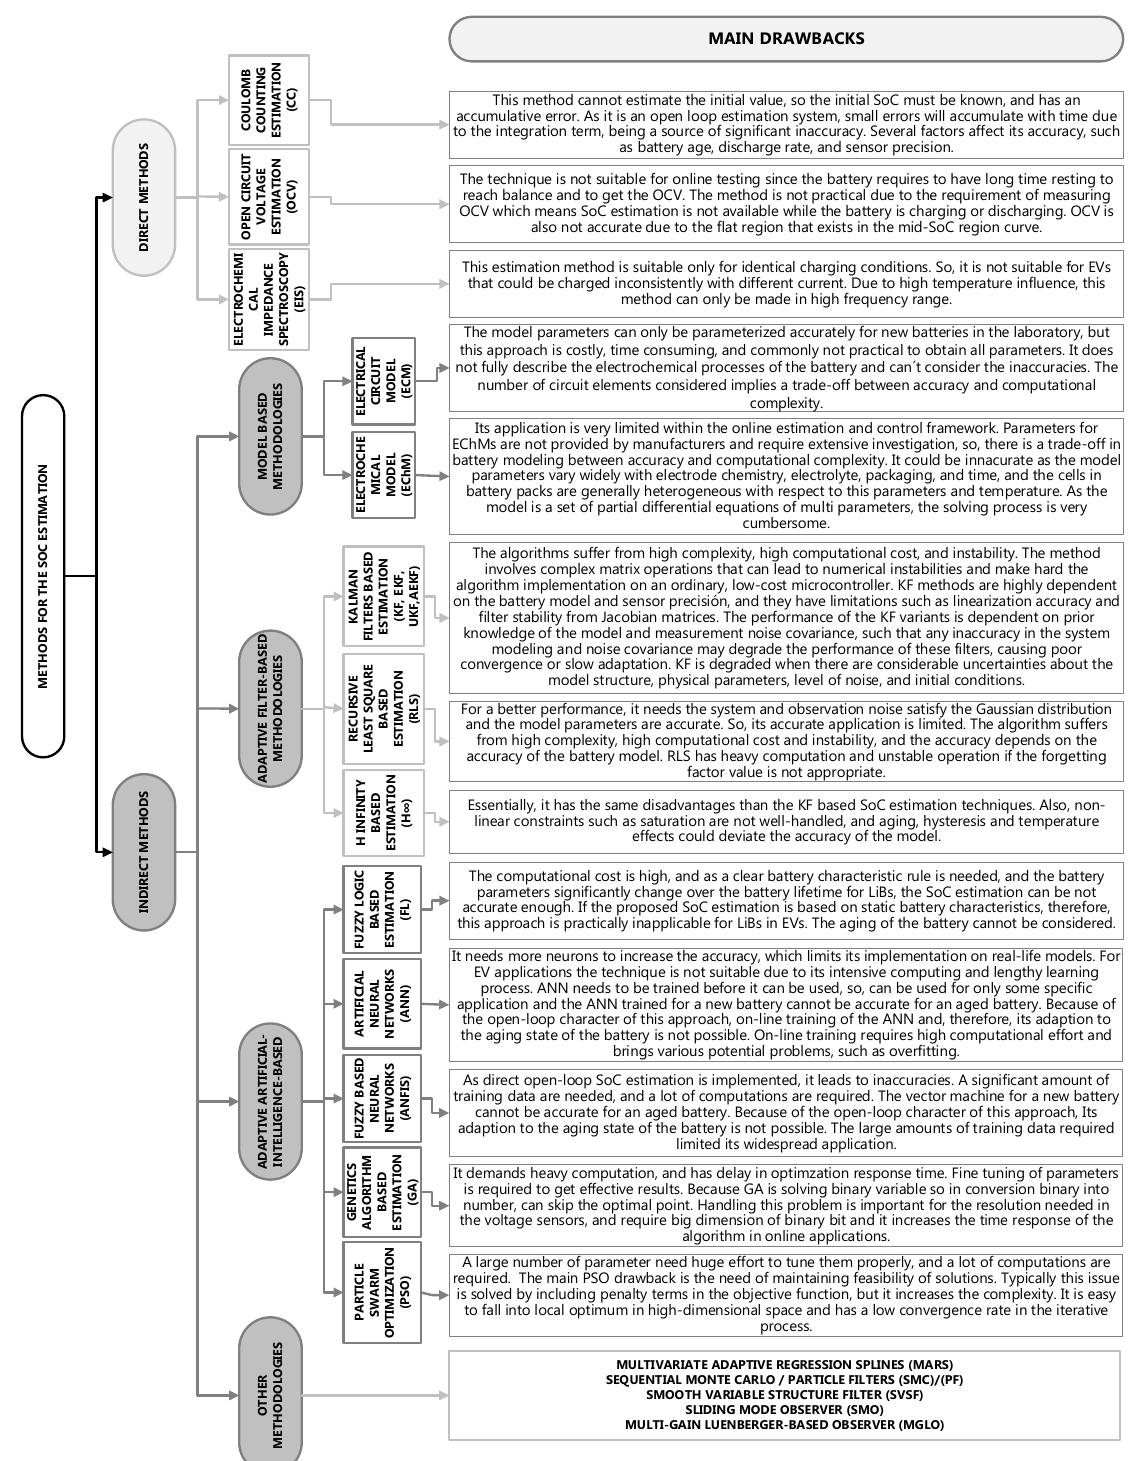
Figure 3. Summary of methods for the SoC estimation and main disadvantages.